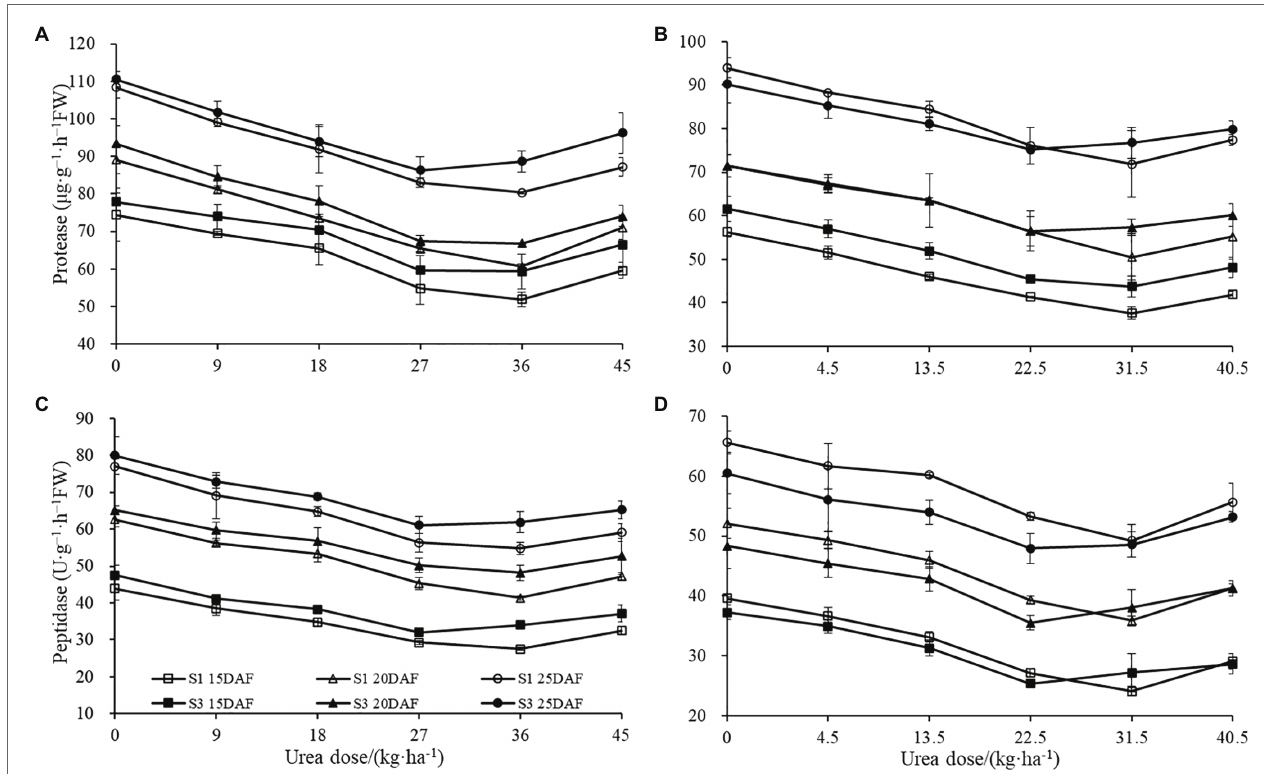
FIGURE 6 | The boll shell protease and peptidase activities under different urea doses in 2017 (A,C) and 2018 (B,D) . FW represents the fresh weight of the sample, DAF represents the abbreviation of “days after flowering,” and S1 and S3 represent the Sikang 1 and Sikang 3, respectively.